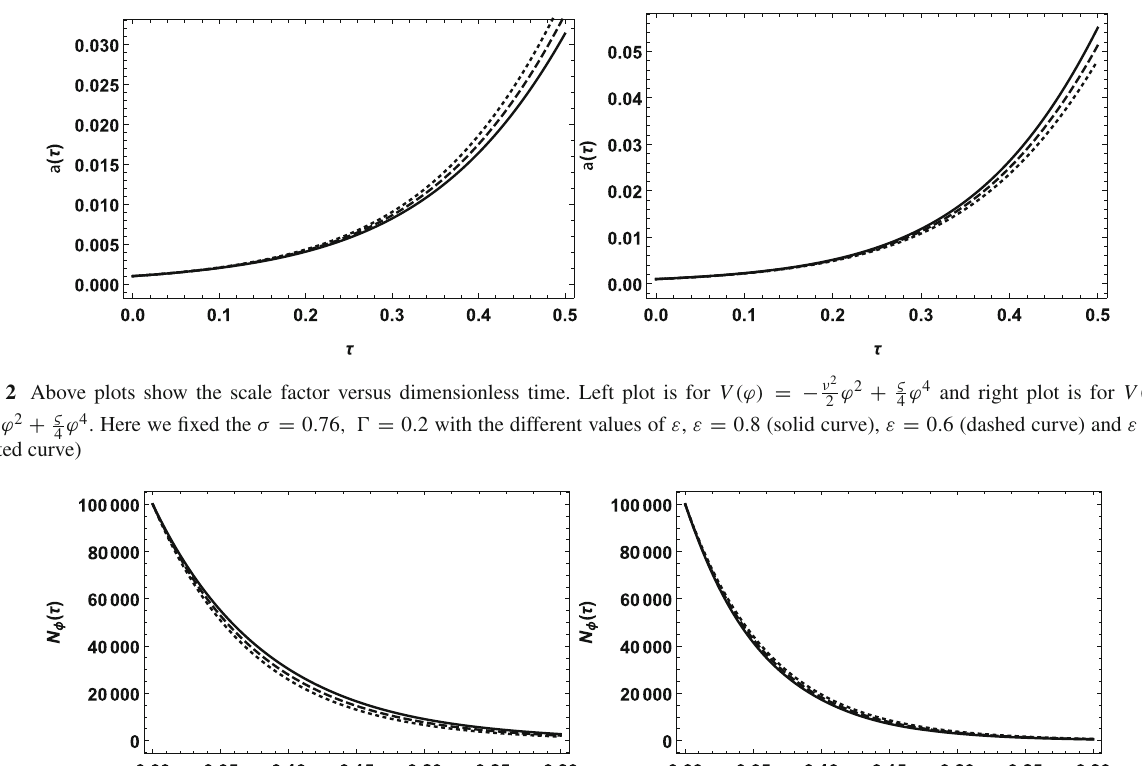
Fig. 3 Above plots show the scalar-field particle number, N ϕ versus dimensionless time. Left plot is for V (ϕ) = − ν 2 ϕ 2 + ς ϕ 4 . Here we fixed the σ = 0 . 76 , (cid:8) = 0 . 2 with the different values of ε , ε = 0 . 8 (solid curve), ε = 0 . 6 (dashed curve) and for V (ϕ) = + ν 2 2 4 ε = 0 . 4 (dotted